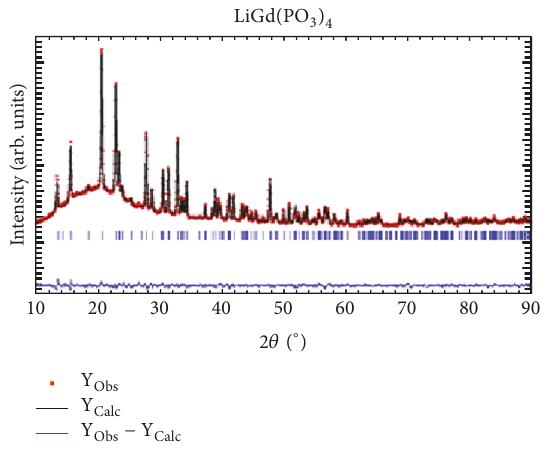
Figure 1: The Rietveld analysis of X-ray diffraction patterns for LiGd(PO 3 ) 4 .